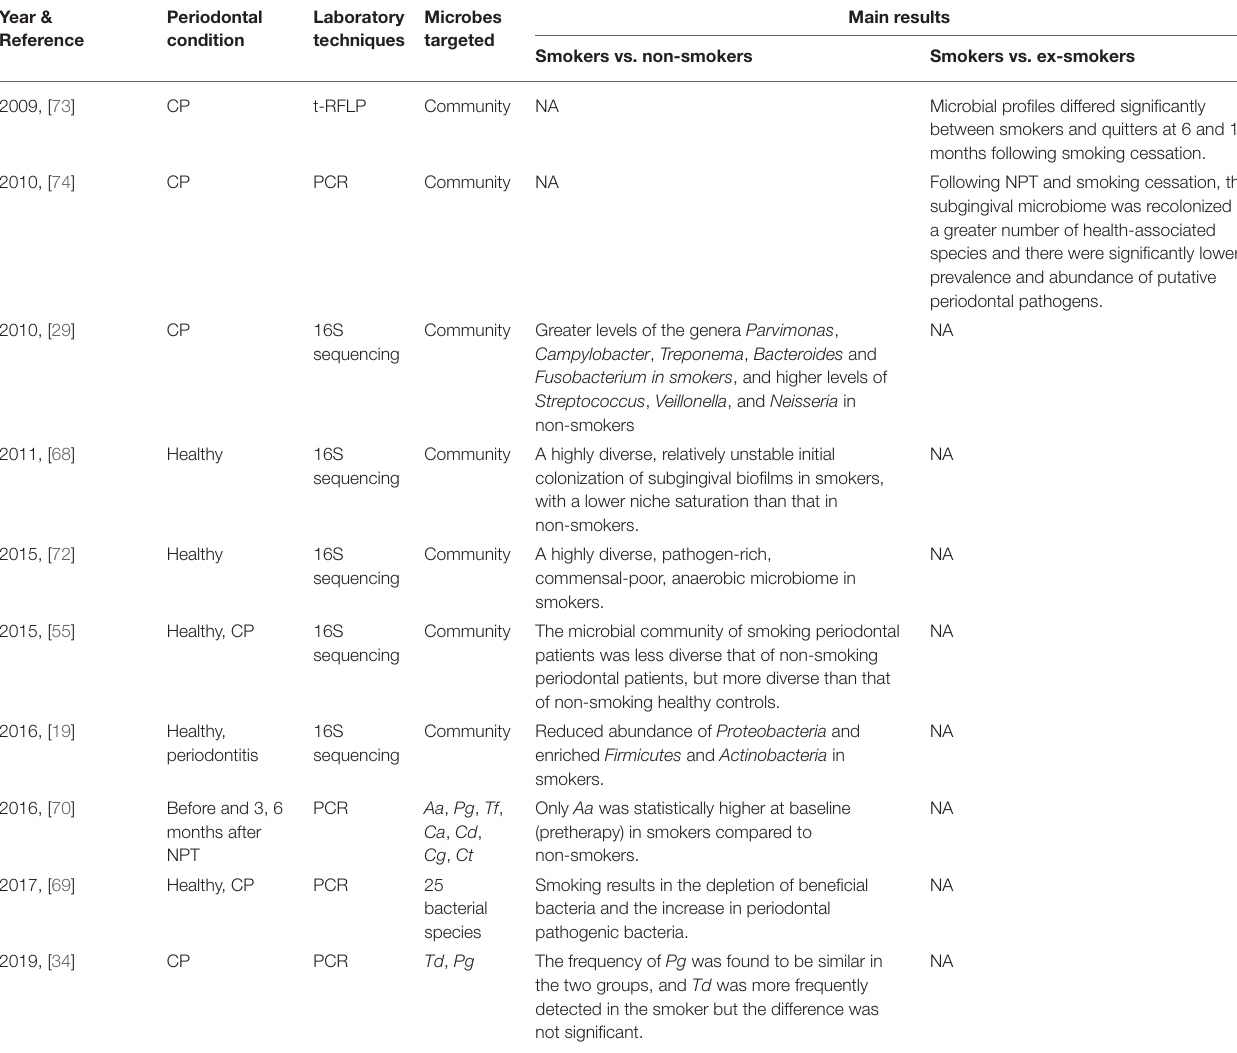
TABLE 1 | Clinical studies on the effects of smoking on abundance and diversity of subgingival microbiota (published between 2006 and